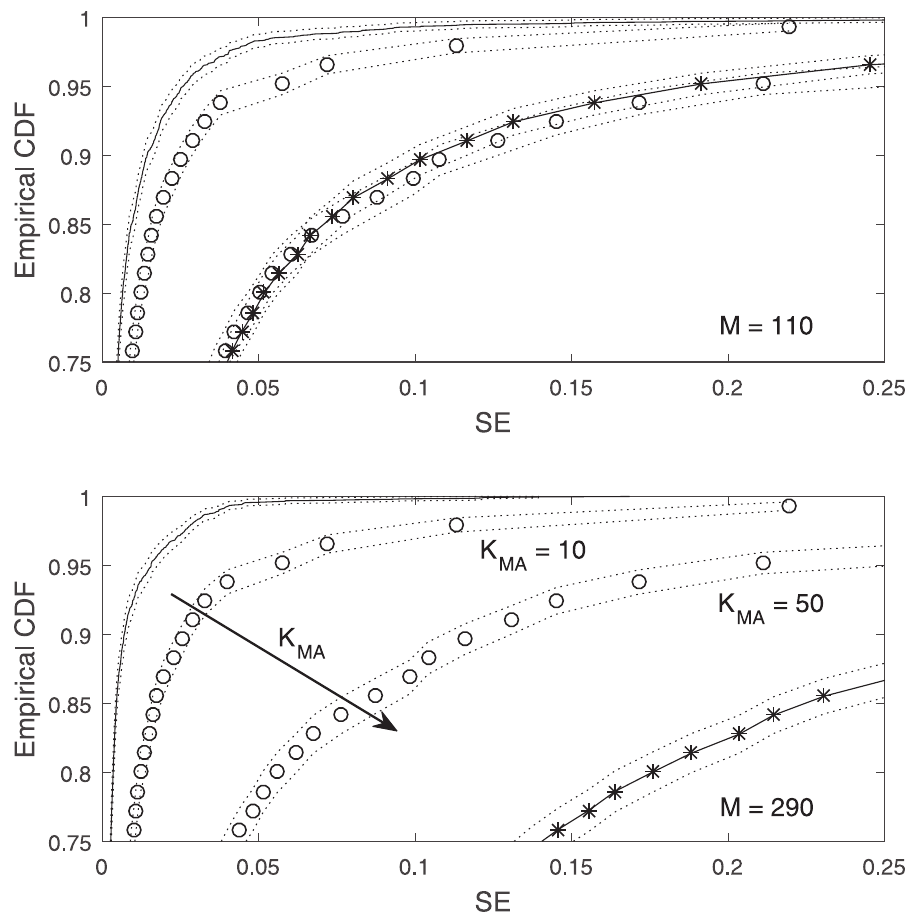
Fig 3. Empirical CDF of SE corresponding to M = 110 and 290. MA 20 and MA 50 : − o − , GB: − � − , RD: Solid lines. Dashed lines illustrate a two standard deviation confidence interval. Plots toward the top and left represent better